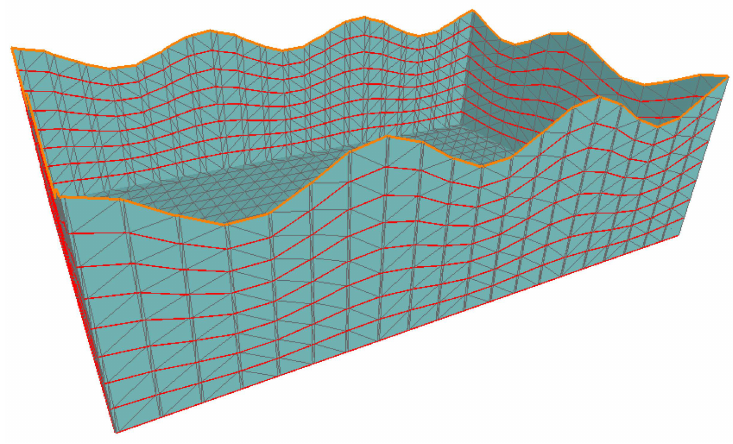
Figure 3. Fundamental body.